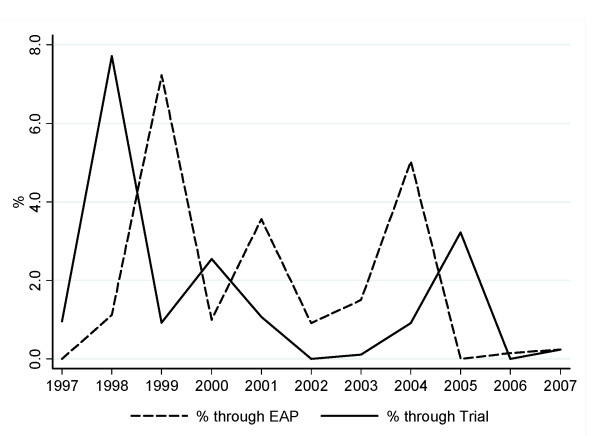
Proportion of regimen initiation/changes involving an experimental antiretroviral by calendar year.